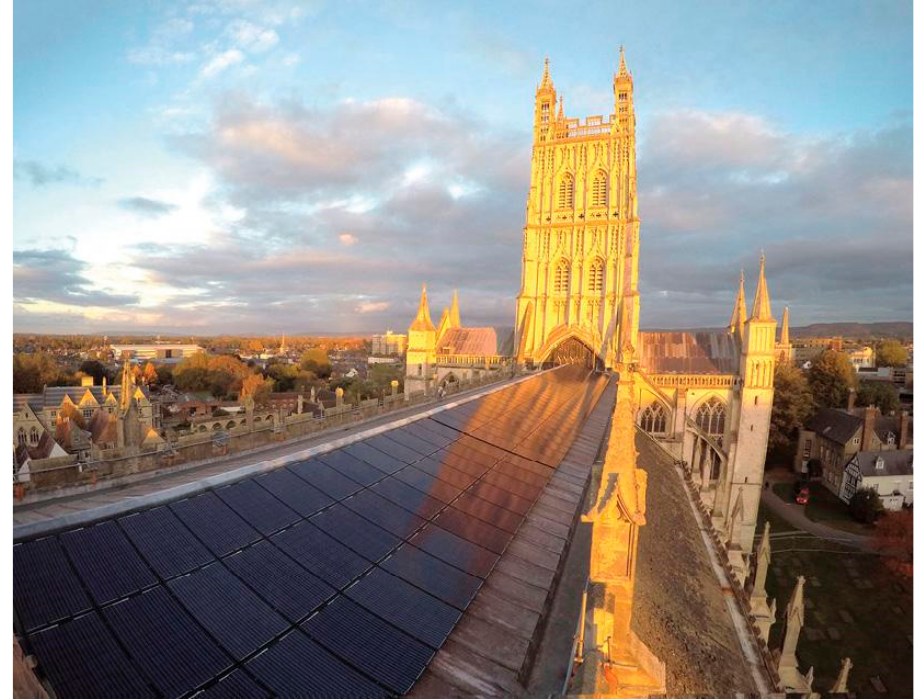
Figure 9. Gloucester Cathedral reduced the electricity bill by